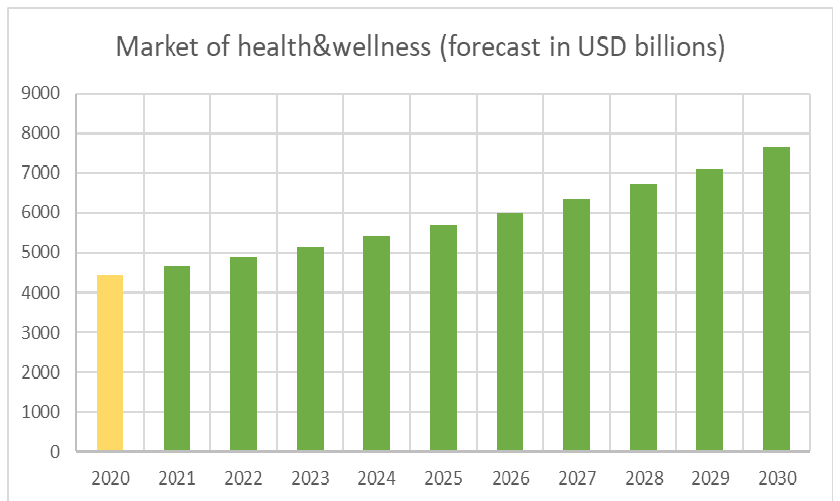
Figure 10. Forecasted health and wellness market size, from 2020 to 2030, based on market data [64].